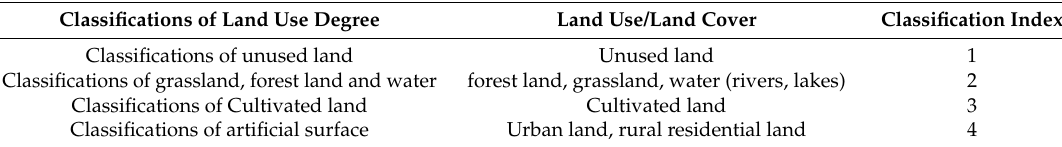
Table 3. Classifications index of land